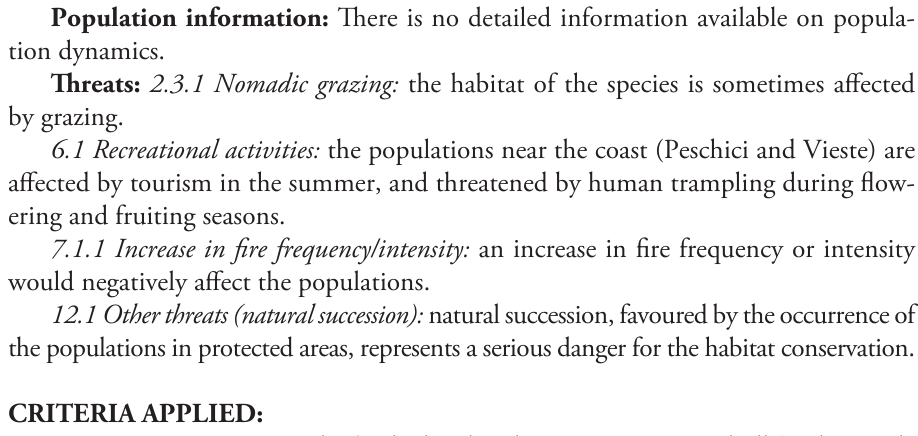
Population information: There is no detailed information available on popula- tion